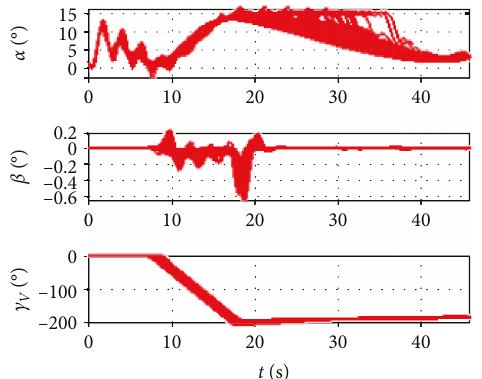
Figure 22: 3D trajectory curve in the dive phase.